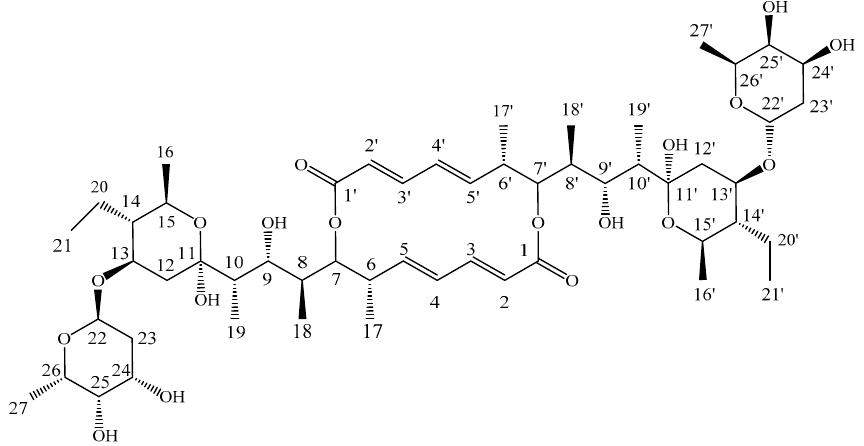
Figure 9. Structure of Azalomycin B. Structural elucidation of compound 1: Azalomycin B, C 54 H 88 O 18 , white microcrystals. UV (MeOH) λ max 252nm; electrospray ionization (ESI) MS m / z : 1047 [M + Na] + ; 1 H NMR (600 MHz, MeOD) δ H 6.93 (1H, dd, J = 15.2, 11.2 Hz, H-3), 6.17 (1H, dd, J = 15.0, 11.2 Hz, H-